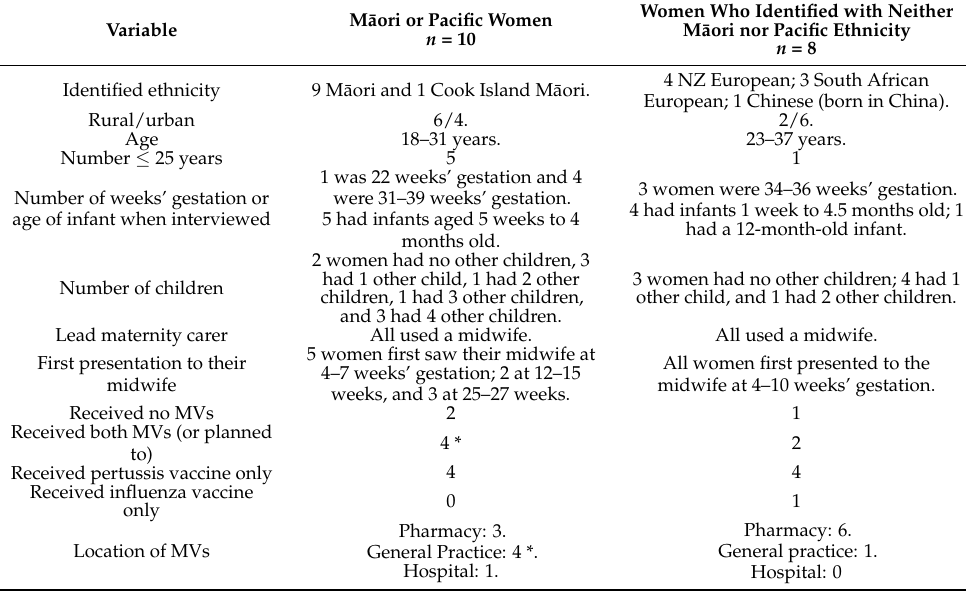
Table 1. Characteristics of the enrolled and interviewed women ( n = 18).